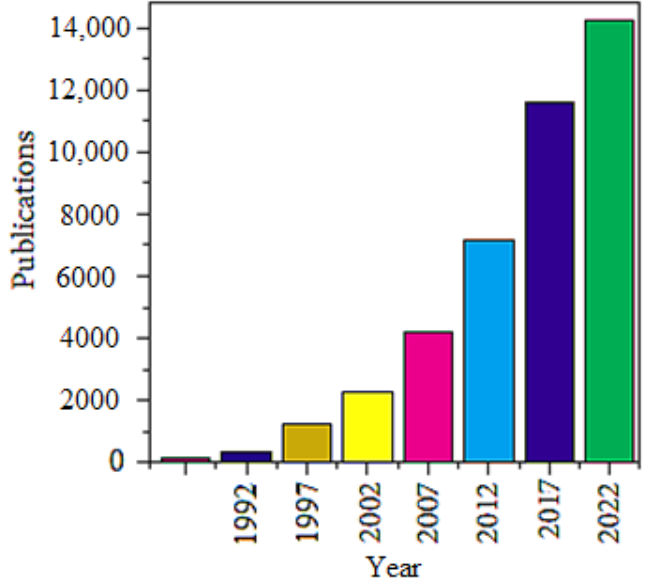
Figure 1. Publication trend of graphene since 1990 – 2022.